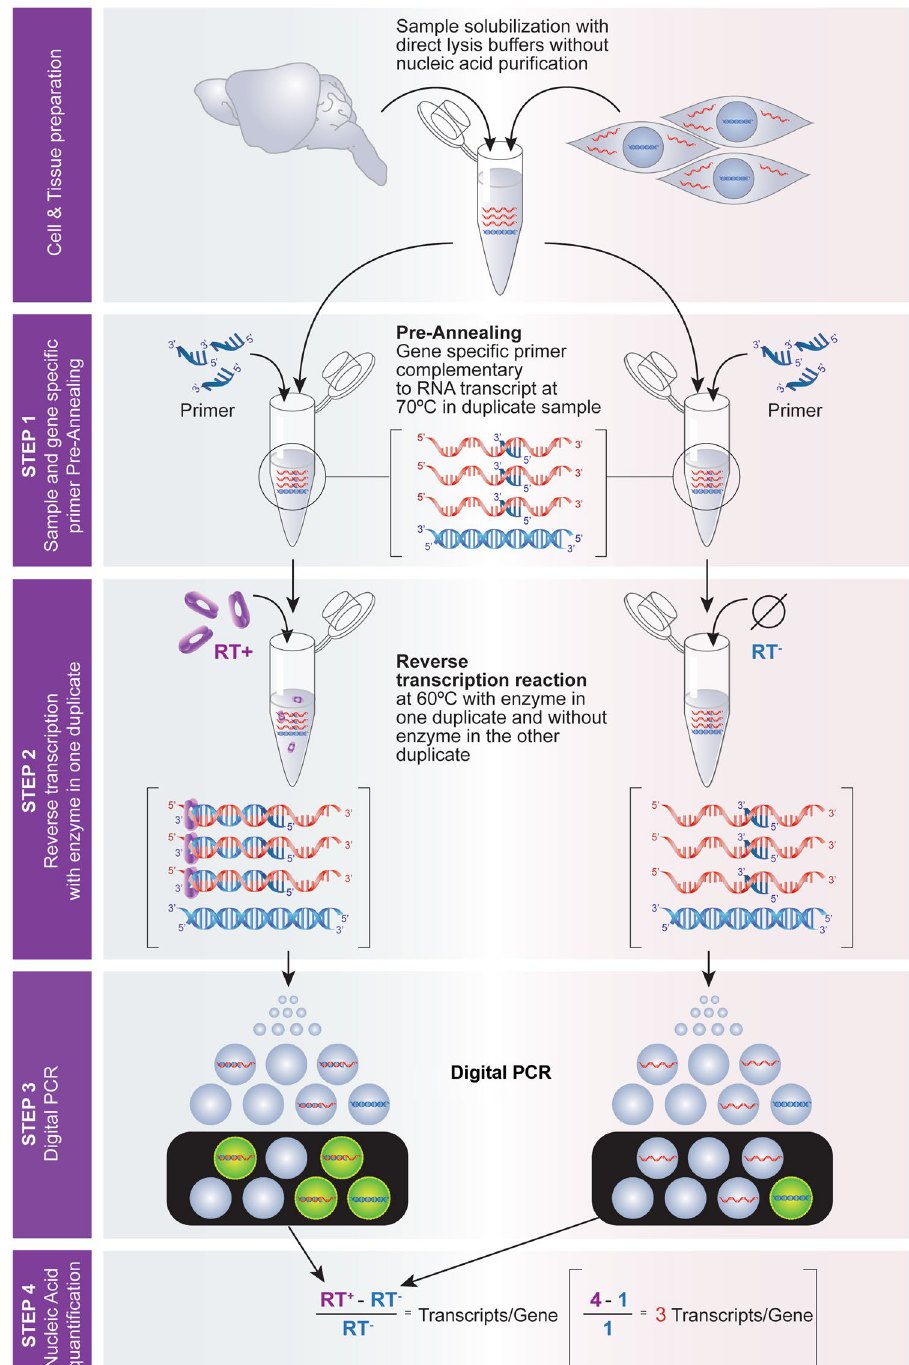
Figure 1. Diagram of the Selfie digital PCR method (Selfie-dPCR) to analyze gene transcription in relation to the self-encoding gene. Selfie-dPCR measures the amount of DNA and cDNA directly in a cell or tissue lysate that contains native proportions of nucleic acids. It includes four steps: 1) sample and gene-specific primer pre-annealing in duplicate, 2) reverse transcription with enzyme in one duplicate (RT + ) and without enzyme (RT − ) in the other duplicate, 3) digital PCR and 4) nucleic acid quantification. This method allows for the measurement of an RNA transcript in relation to the gene encoding the transcript, thus yielding the absolute number of transcripts/gene at the time of cell or tissue lysis. Diagram drawn by Iris